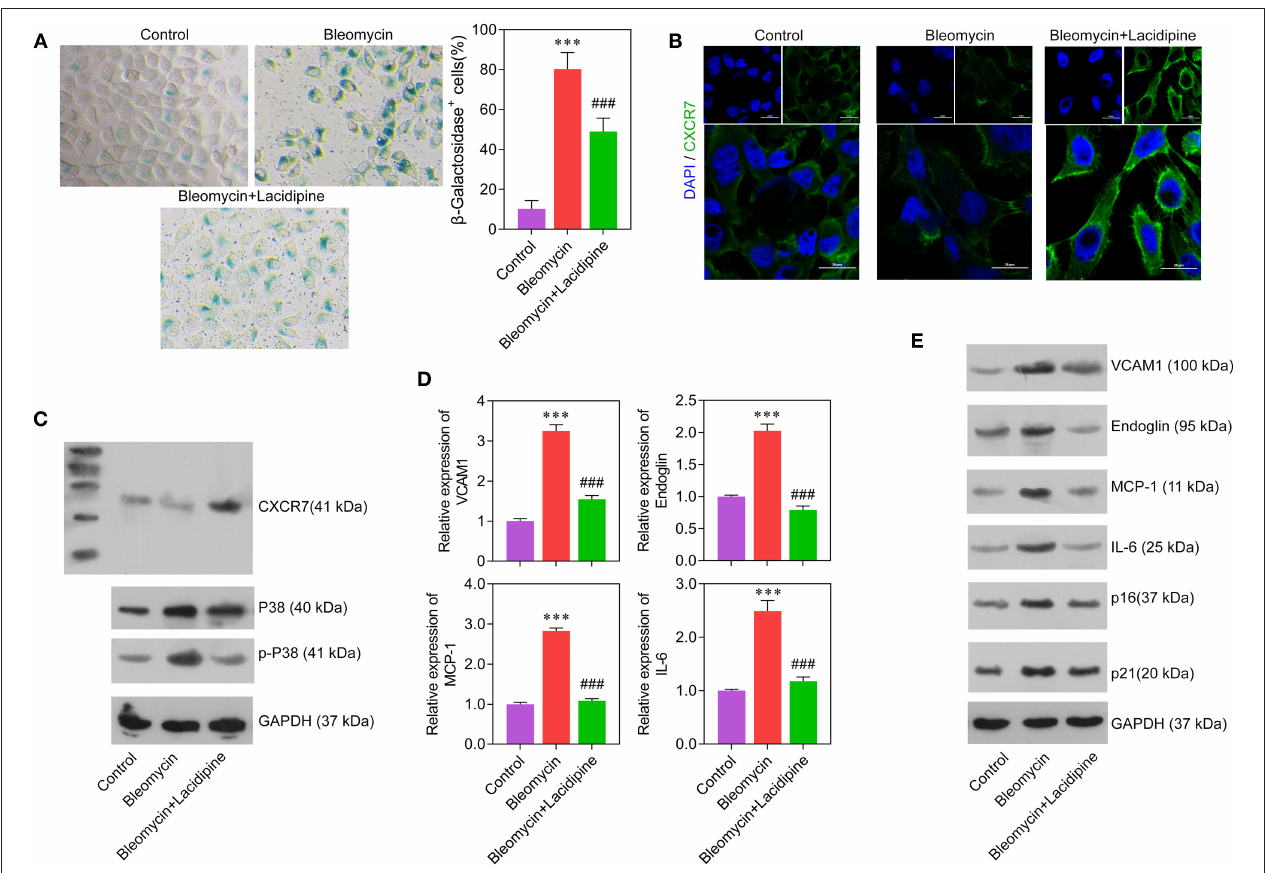
FIGURE 3 | Lacidipine inhibited endothelial senescence and promoted CXCR7 expression. Cultured ECs were treated with Lacidipine, followed by bleomycin stimulation (senescence induction). Cell senescence was determined through β -galactosidase staining (A) . Immunofluorescence assay was applied to determine the protein expression of CXCR7 (B) . Western blot was performed to analyze the protein expression of CXCR7, P38, and p-P38 (C) . qPCR (D) and Western blot were performed to analyze the levels of VCAM1, Endoglin, MCP-1, IL-6, P16, and P21 (E) . (Data are mean ± SD of three independent experiments. *** p < 0.001, compared with the control group; ### p < 0.001, compared with the bleomycin